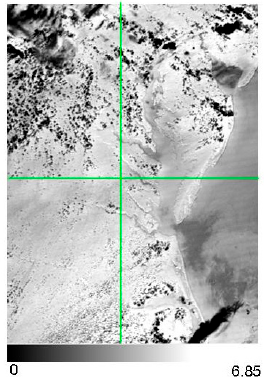
Figure 9. MYD05_L2 product in America.